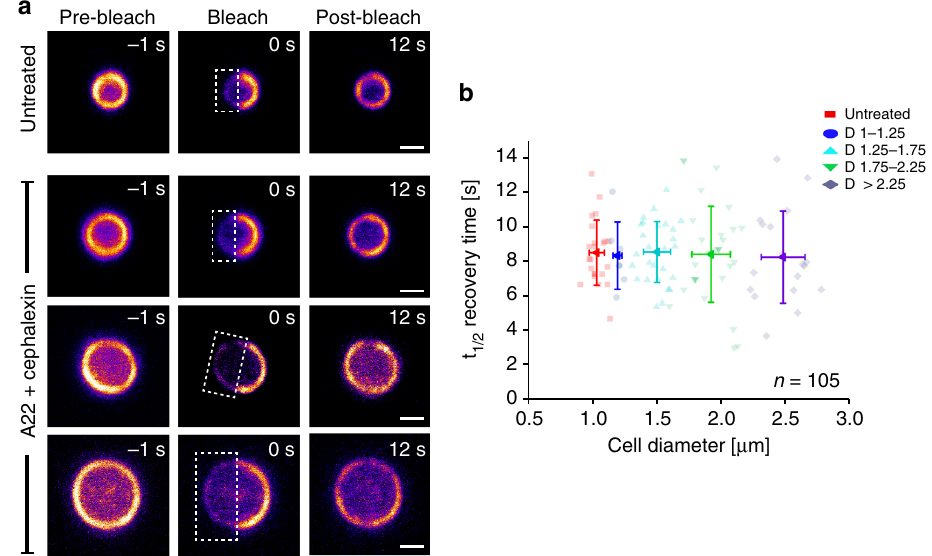
Fig. 2 Cell size independent recovery of fl uorescence in FtsZ-rings. FRAP measurements on FtsZ-GFP rings in E. coli cells trapped standing in a vertical position. a Representative cells of different diameter, untreated or treated with drugs. White boxes indicate bleached areas. Scale bars = 1 μ m. b Quanti fi cation of FRAP data from untreated cells (red), and drug-treated cells (other colors), showing that fl uorescence recovery time is independent of cell diameter (in the range investigated, i.e., ~ 1 – 3 μ m). n tot = 105. D = cell diameter range. Mean t 1/2 recovery time WT FtsZ-rings was 8.4 ± 1.9 s (mean ± S.D., n = 23, red squares), while for large FtsZ-rings, recovery times were 8.2 ± 1.9 s ( n = 7, dark blue circles), 8.4 ± 1.7 s ( n = 27, light blue triangles), 8.3 ± 2.8 s ( n = 30, green triangles) and 8.2 ± 2.6 s ( n = 18, purple diamond) for cells with diameters in the ranges of 1 – 1.25 μ m, 1.25 – 1.75 μ m, 1.75 – 2.25 μ m and > 2.25 μ m, respectively. Error bars represent S.D. Note that FRAP measurements on fi xed cells indicated that trapped cells were stationary, and not